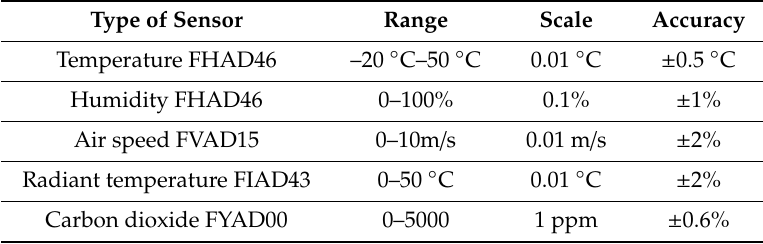
Table 5. Type of sensors and their measurement range.